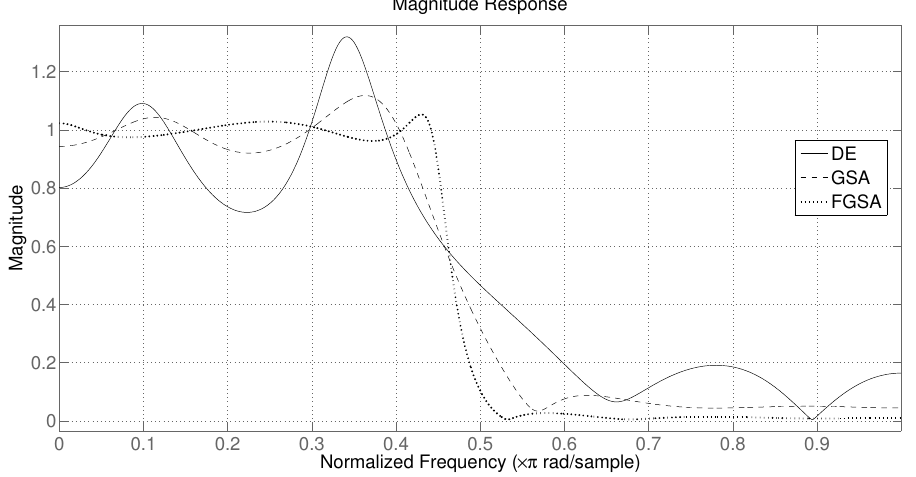
Figure 7. Magnitude response over normalized frequency for 8th order IIR Low Pass filter using Differential Evolution, Gravitational Search Algorithm and Fuzzy Gravitational Search